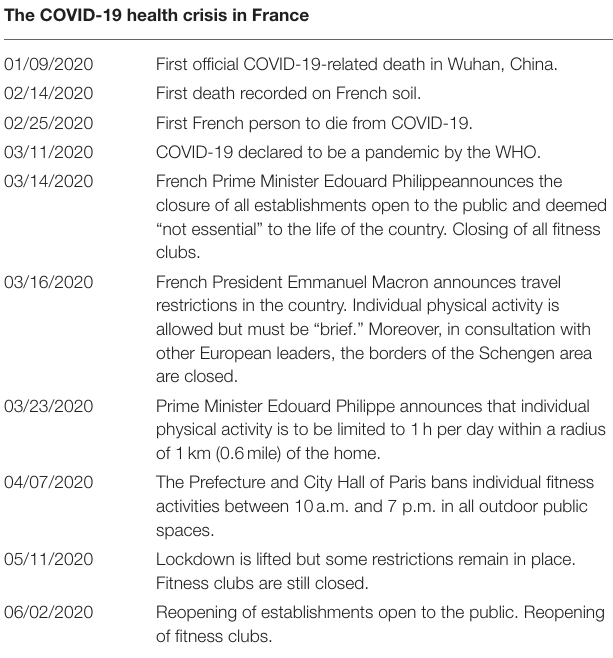
TABLE 1 | The French national regulations on physical activities during the COVID-19 pandemic, between 14 February and 2 June, 2020. The COVID-19 health crisis in